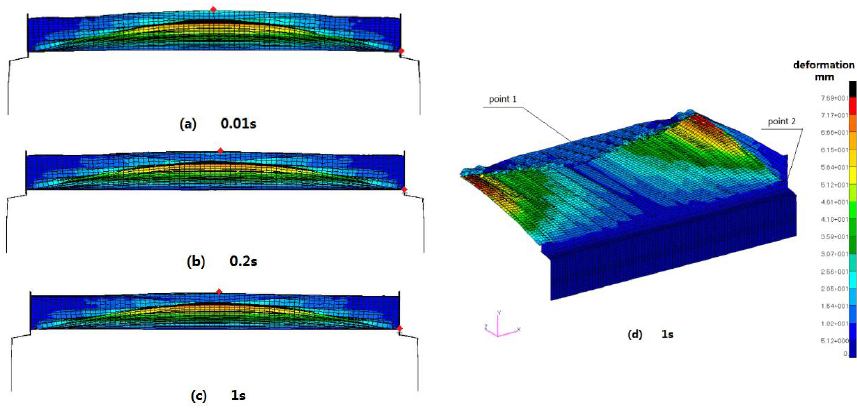
Figure 8. Deformation of the ARBW. ( a ) the moment of 0.01 s, ( b ) the moment of 0.2 s, ( c ) the moment of 1 s, ( d ) the moment of 1 s in isometric view.